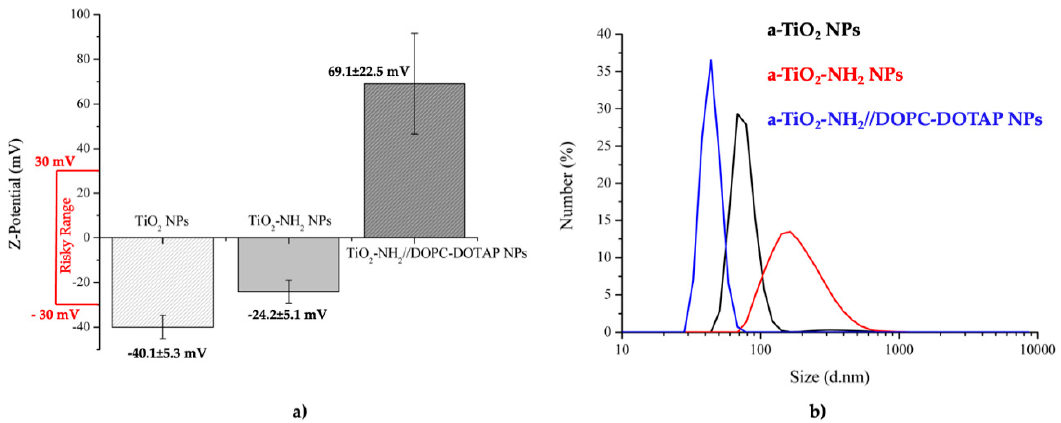
Figure 3. Z-potentials and hydrodynamic diameters of pristine a-TiO 2 NPs, a-TiO 2 -NH 2 NPs, and a-TiO 2 -NH 2 //DOPC-DOTAP NPs suspended in milliQ water: ( a ) Z-potential measurements; ( b ) dynamic light scattering measurements in number (%).